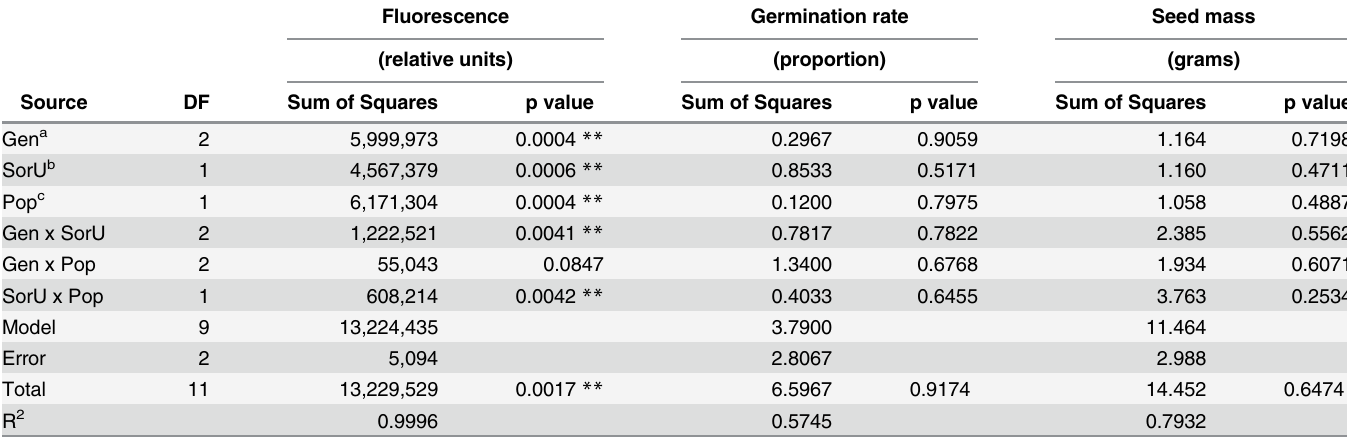
Table 1. Analysis of variance of fluorescence, germination rate, and seed mass.